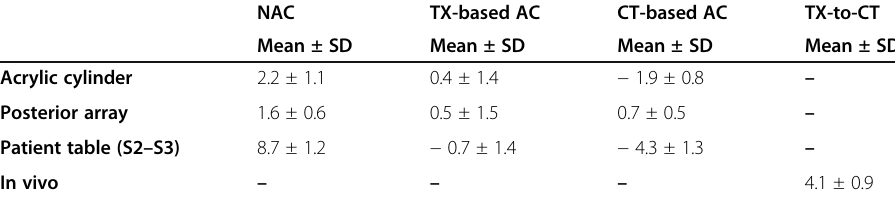
Table 1 Relative percentage difference for non-corrected and corrected images of hardware to nonattenuation-corrected and attenuation-corrected image of blank scan. In vivo data from TX- based AC and CT NAC TX-based AC